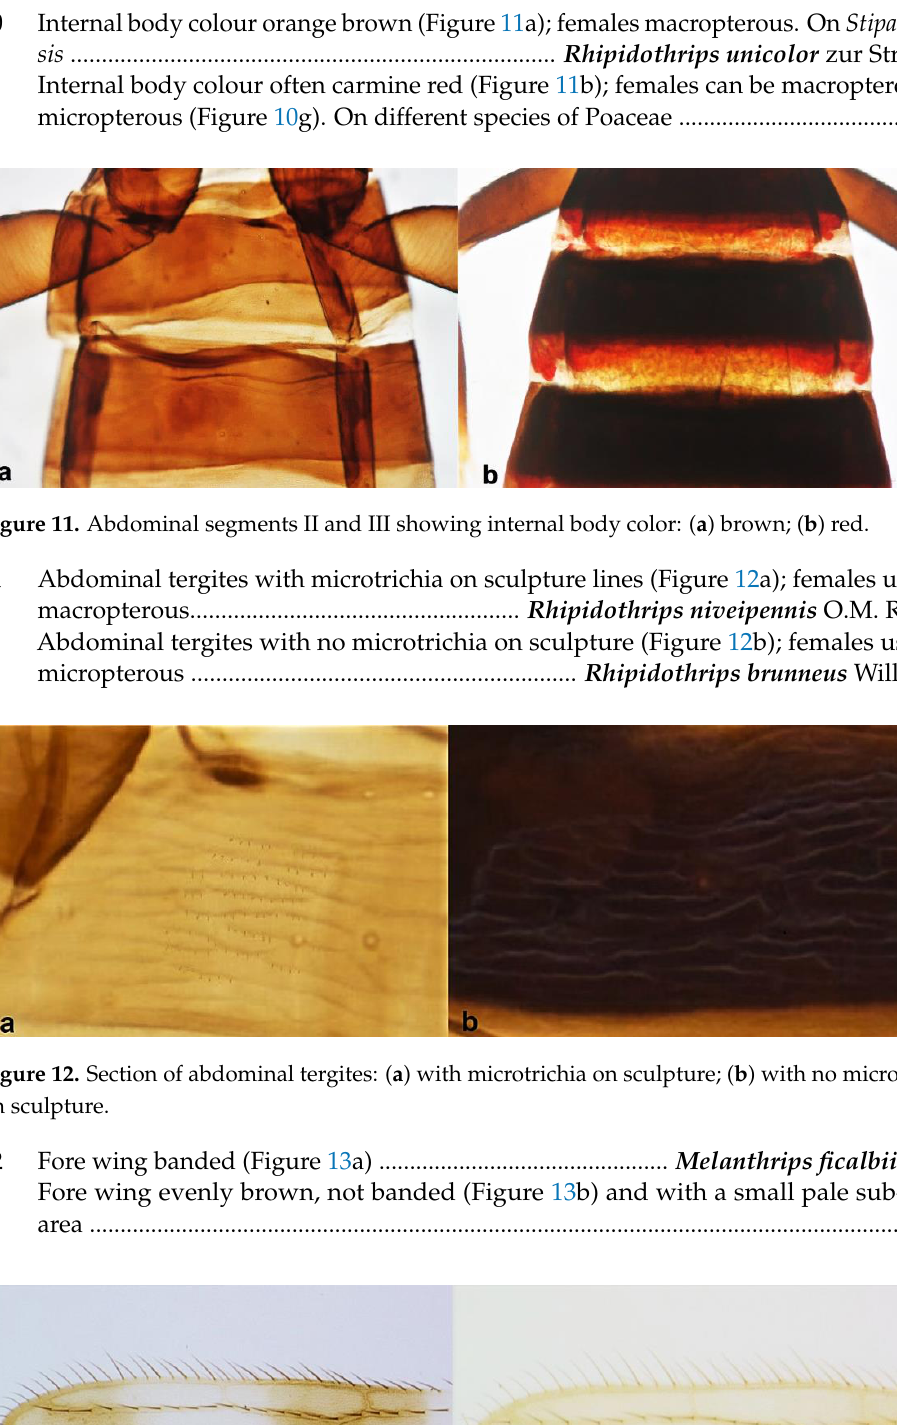
Anterior margin of fore wing between transverse veins with two rows of setae (Figure